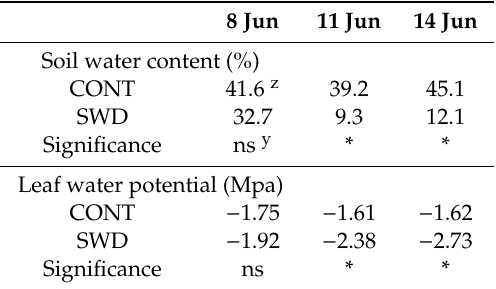
Table 1. Changes in the soil water content and the leaf water potential at mid-morning during soil water deficit (SWD) treatment.